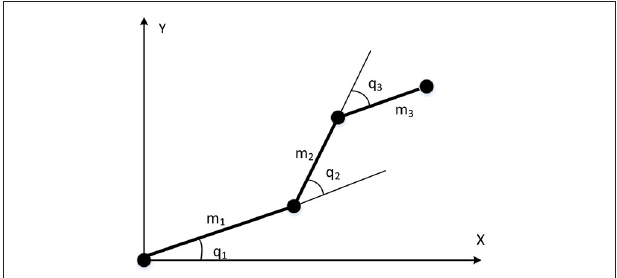
FIGURE 4 | The three-links robot